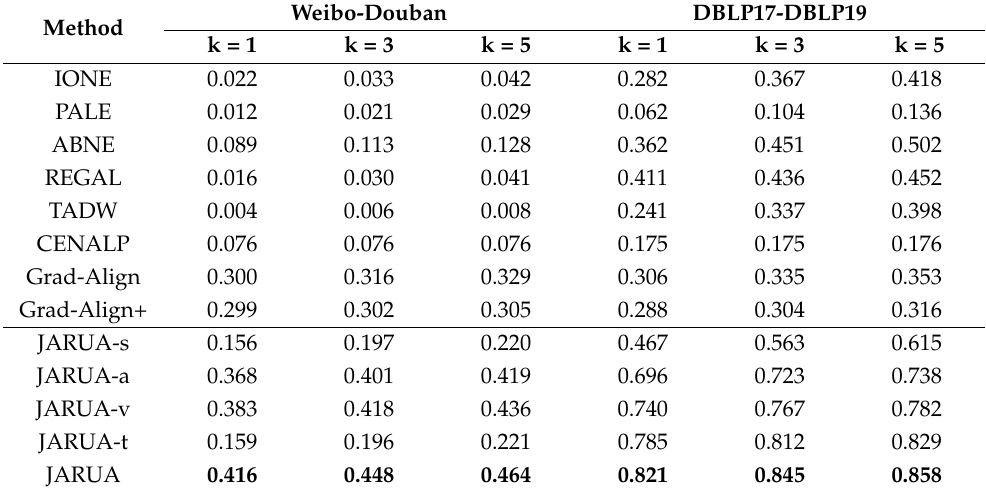
Table 3. Hit-Precision scores of all comparison